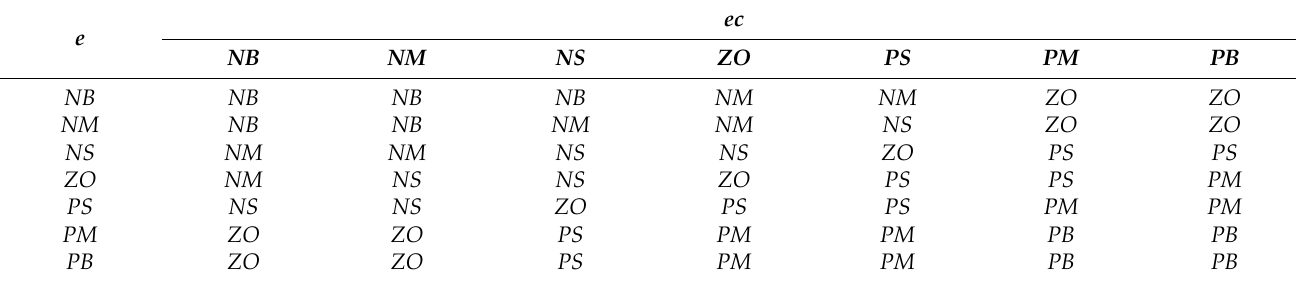
Table 3. Ki fuzzy control rules